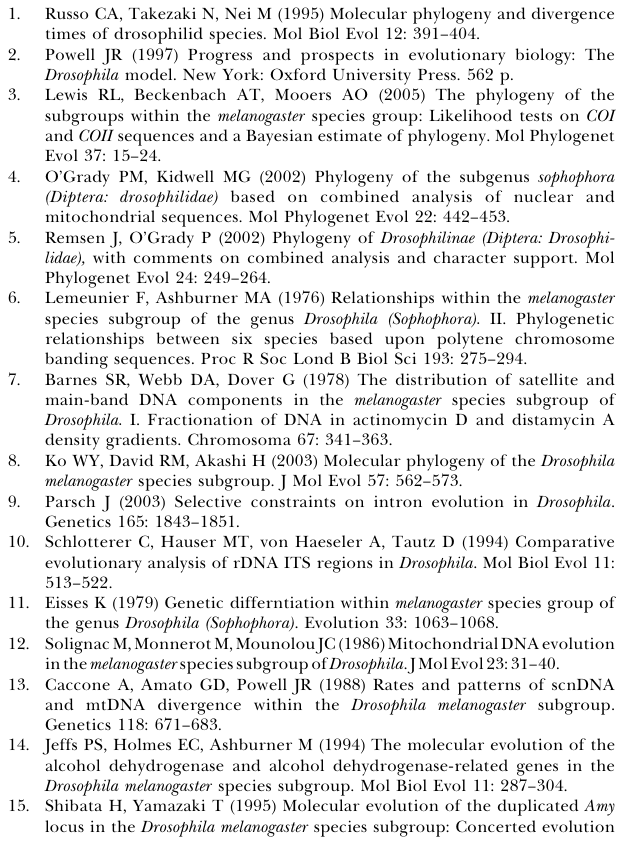
Figure S8. dN/dS